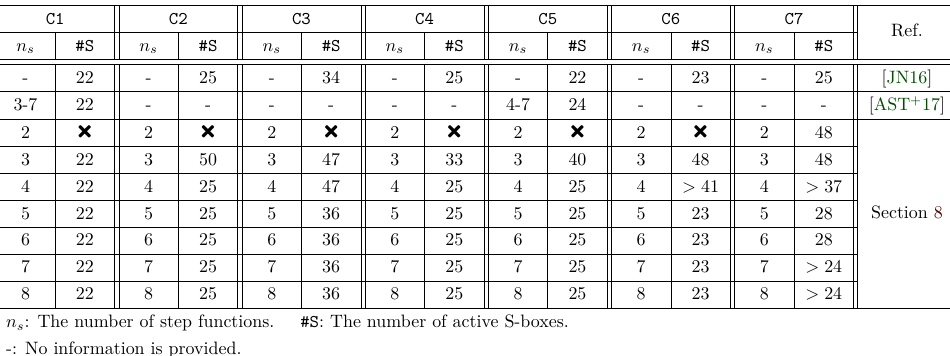
Table 9: Lower bound on the number of active S-boxes for C1 - C7